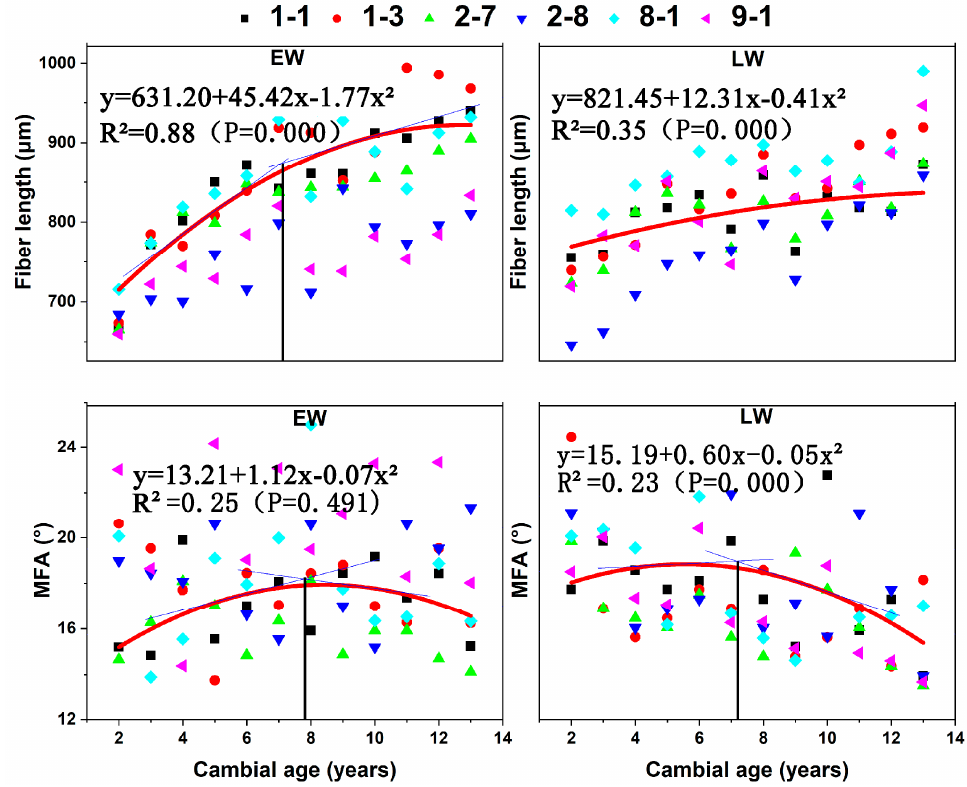
Figure 5. Variation in earlywood (EW) and latewood (LW) in fiber length and microfibril angle (MFA) revealed the demarcation between the juvenile and mature wood zones from six C . bungei clones. The demarcation between juvenile and mature wood zones was calculated through tangent intersection according to the multiple linear regression curves.